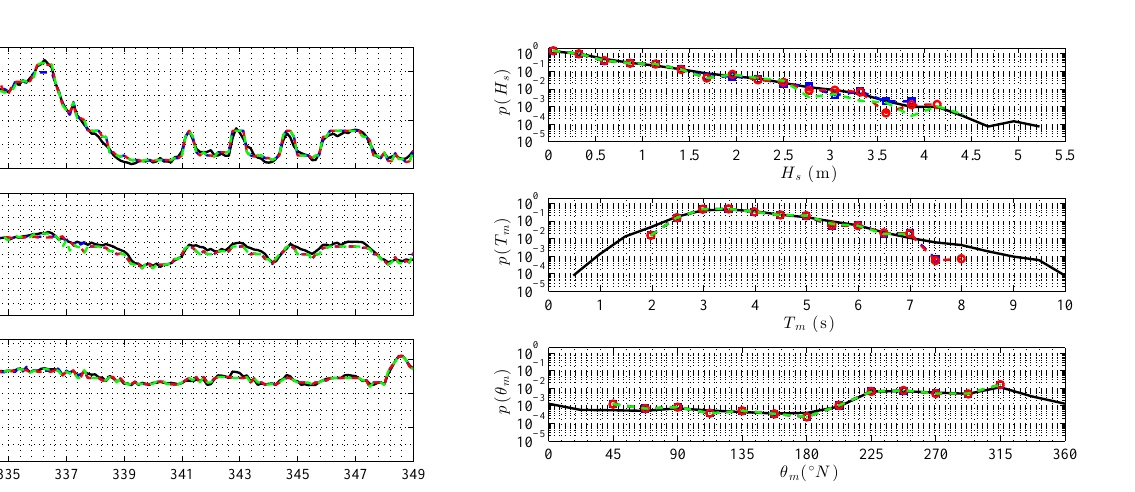
Figure 11. TSOM: comparison between original (black solid lines) and reconstructed time series of H s (top panel), T m (central panel) and θ m (bottom panel), for a chosen sequence of events. Thresh- olds: 95th (blue dashed line), 97th (red dashed line) and 99th (green dashed line) percentile of H s .